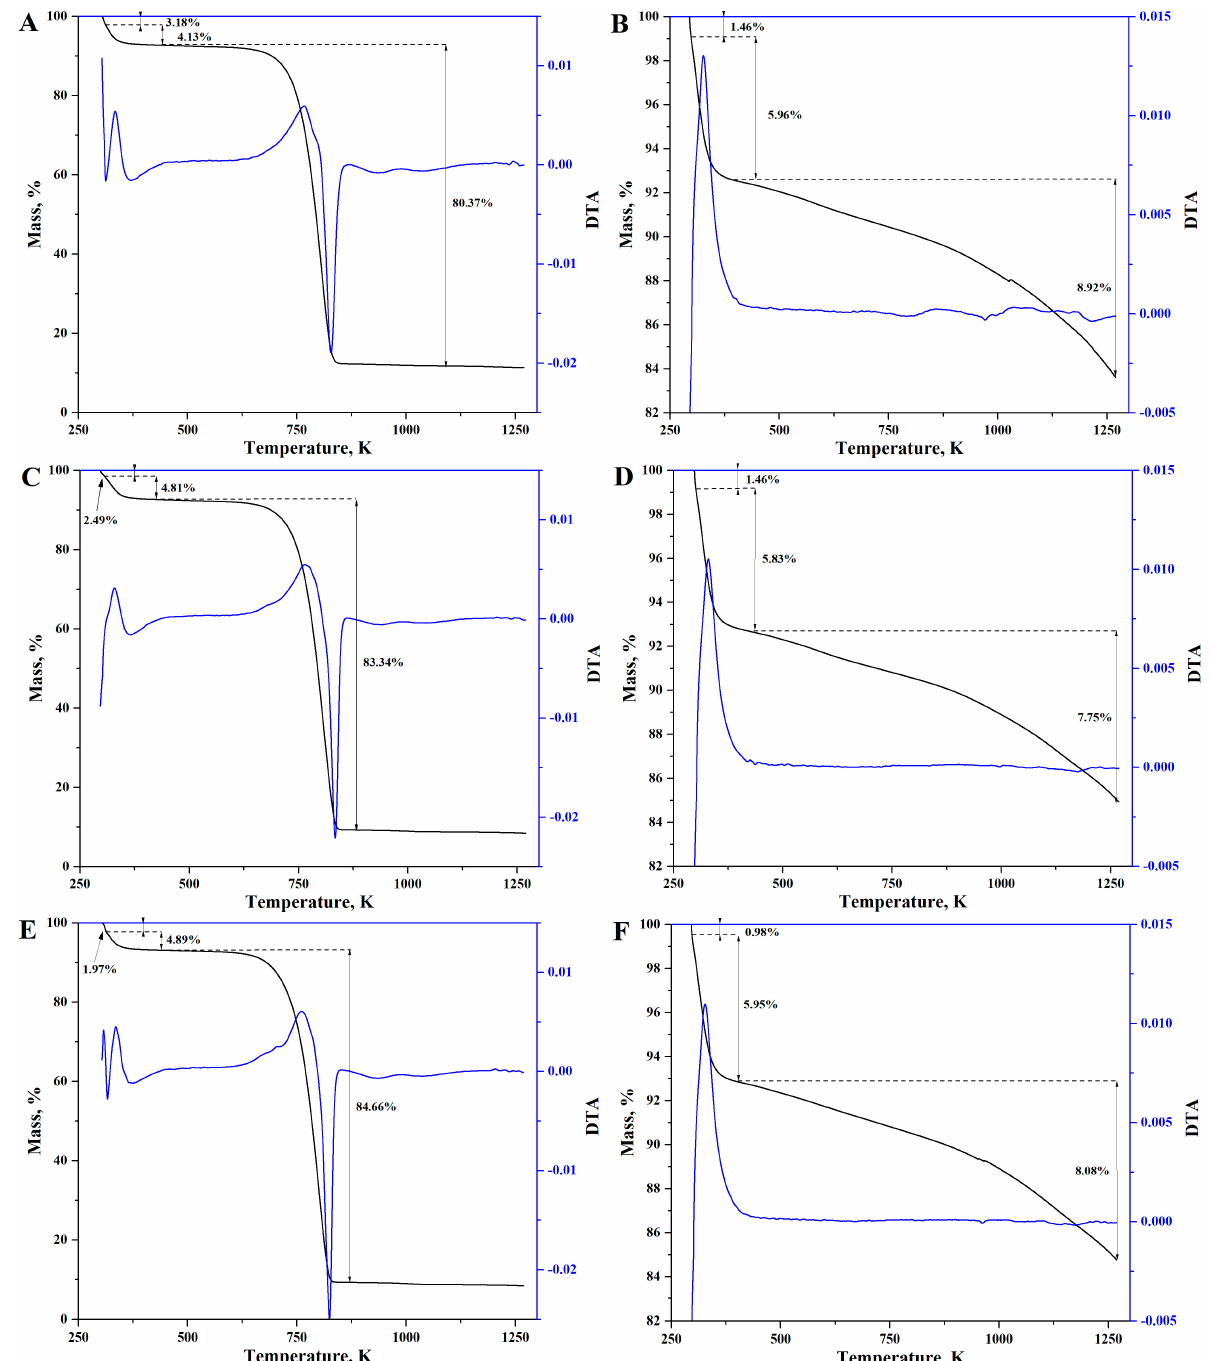
Figure 5. TGA-DTA analysis of biochar–silicon composites; ( A , B ) R-SiO 2 -2h in air and nitrogen atmosphere respectively; ( C , D ) R-SiO 2 -4h in air and nitrogen atmosphere respectively; ( E , F ) R-SiO 2 - 6h in air and nitrogen atmosphere respectively.